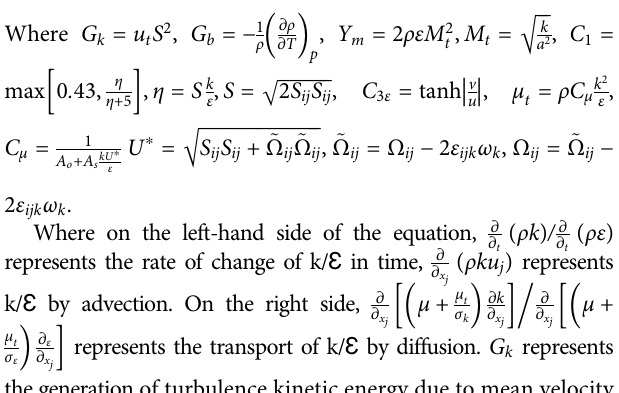
the generation of turbulence kinetic energy due to mean velocity